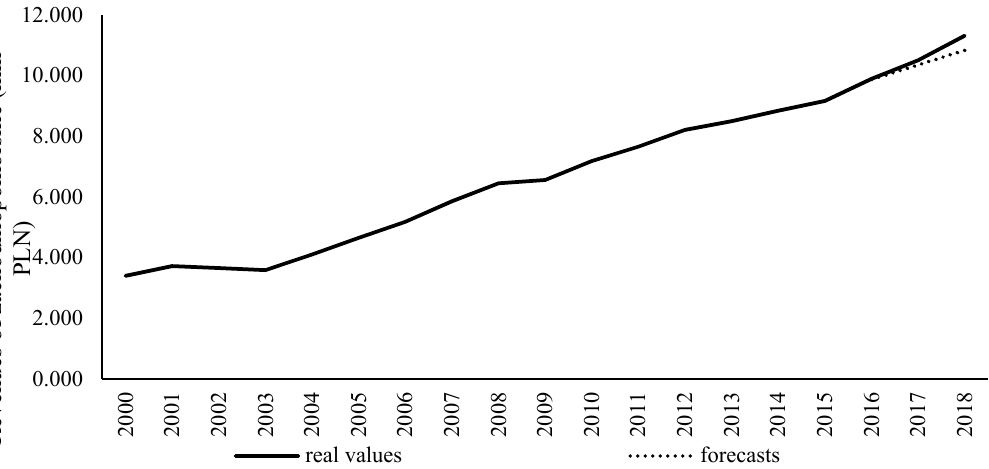
Figure 6. Real values (2000–2018) and forecasts (2016–2018) of revenue of Zachodniopomorskie voivodeship (based on model 9, forecasts of GDP—linear trend and structural forecasts of the gross product of Zachodniopomorskie).